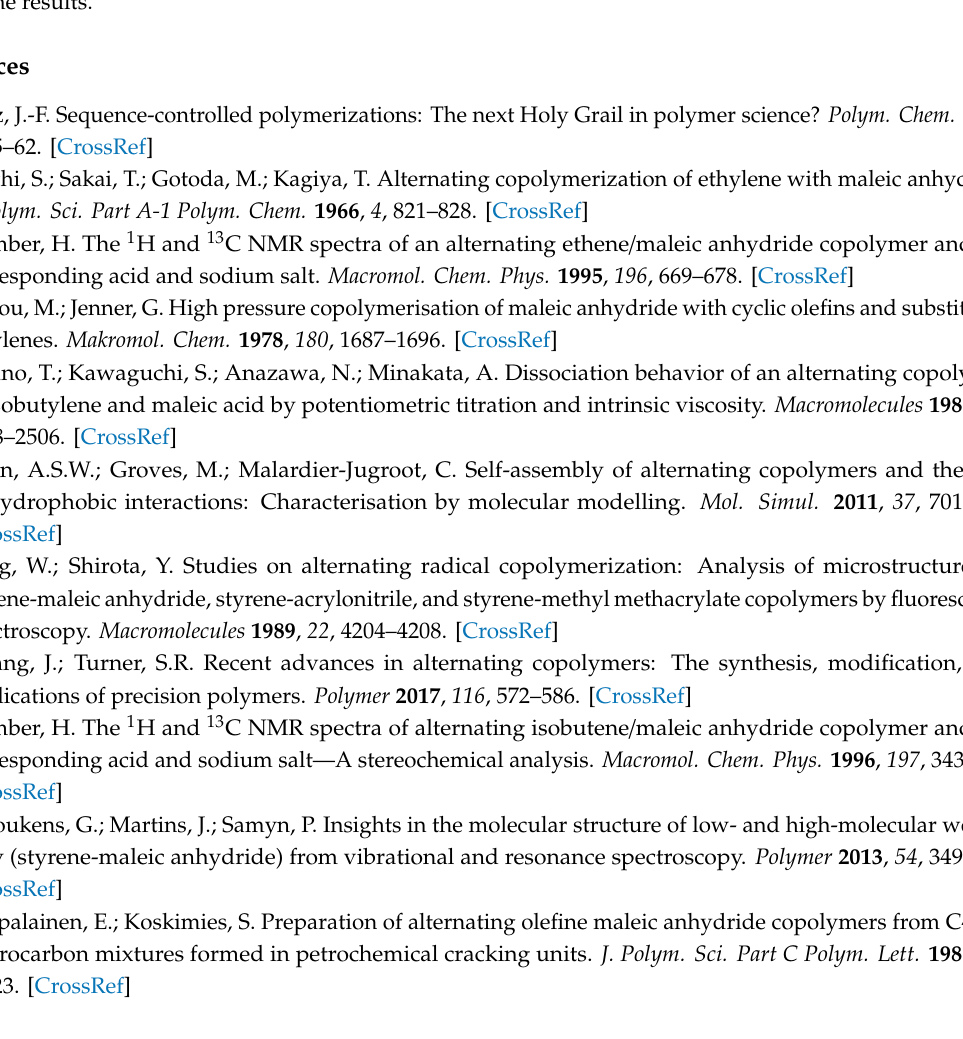
Figure S1: 1H NMR spectrum (CDCl 3 , 20 ◦ C, 400 MHz) of the mixture of MA and 5-methylene-undecane after 2 h at 80 ◦ C, Figure S2: 1H NMR spectrum (CDCl 3 , 20 ◦ C, 400 MHz) of the copolymer of MA and 5-methyleneundecane, Figure S3: 1H NMR spectrum (CDCl 3 , 20 ◦ C, 101 MHz) of the copolymer of MA and 5-methyleneundecane, Figure S4: 1H- 13 C correlation NMR spectrum (CDCl 3 , 20 ◦ C) of the copolymer of MA and 5-methyleneundecane. Optimized geometries, energy parameters and cartesian coordinates for all stationary points and transition